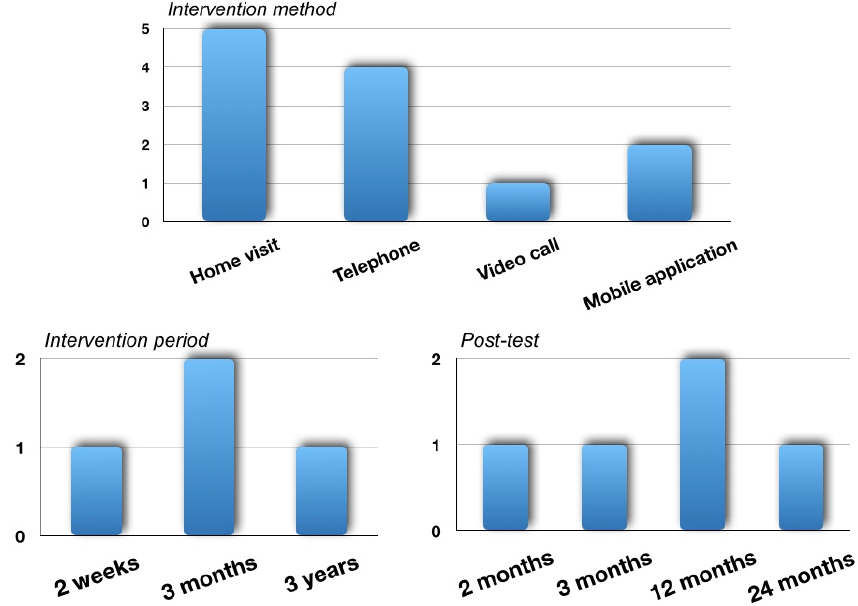
Figure 2. Classification for intervention of follow-up care after NICU